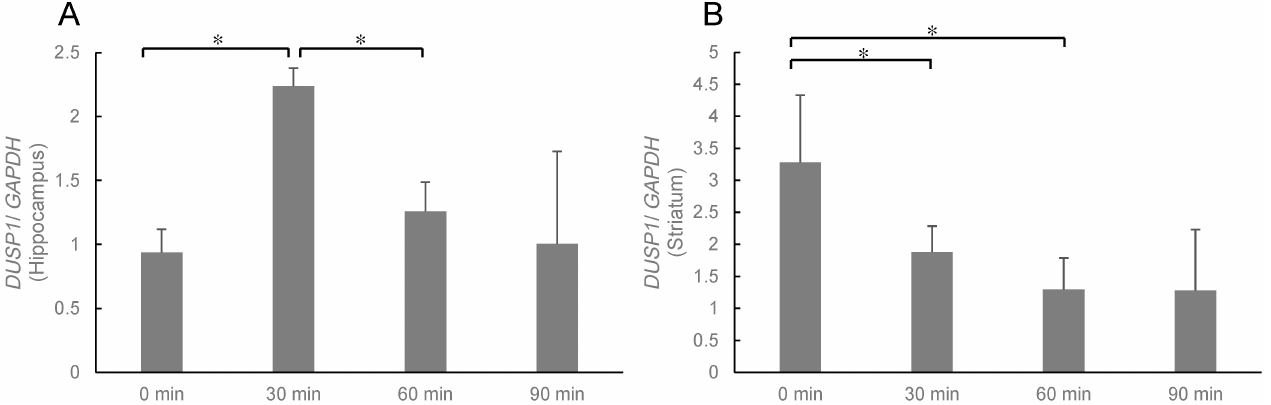
Figure 4. Expression level of DUSP1 in the hippocampus ( A ) and striatum ( B ). Results show means ± SEM (control/saline, stress/saline, control/sesame, stress/sesame, n = 6). * p < 0.05 (two-way ANOVA followed by Tukey’s test or Student’s t -test).